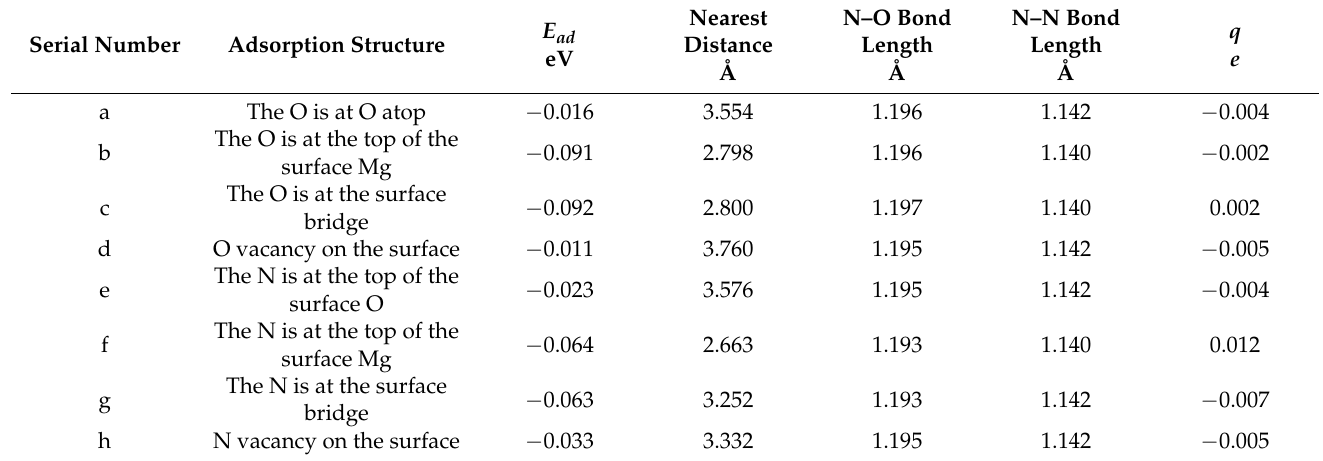
Figure 3. Stable adsorption structure of N 2 O on MgO (100) surface. ( a ) The O is at O atop; ( b ) The O is at the top of the surface Mg; ( c ) The O is at the surface bridge; ( d ) O vacancy on the surface; ( e ) The N is at the top of the surface O; ( f ) The N is at the top of the surface Mg; ( g ) The N is at the surface bridge; ( h ) N vacancy on the surface. Table 1. Adsorption energy, adsorption structure, and charge transfer of N 2 O adsorption on MgO